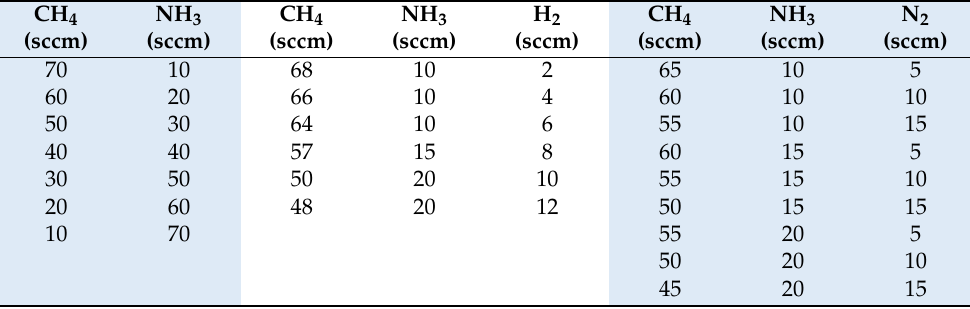
Table 1. Binary and ternary mixture of gases used as